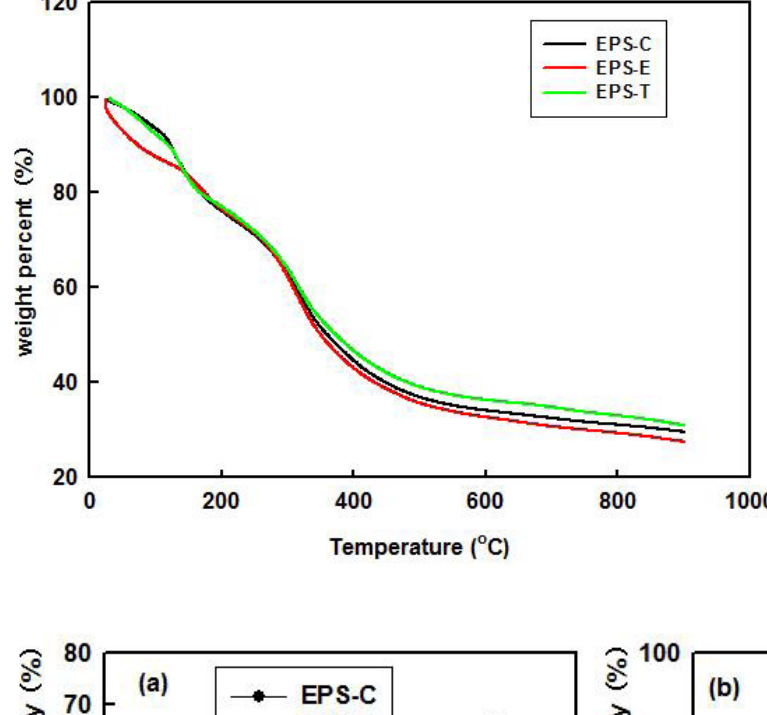
Figure 3. TGA thermogram of the purified EPSs produced by submerged culture of I. rickii by treatment of Tween 40 (EPS-T) and ethanol (EPS-E), respectively. EPS-C means without addition.